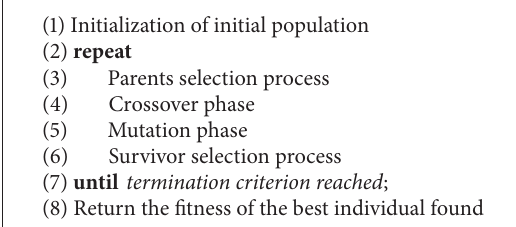
Algorithm 1: Pseudocode of all the